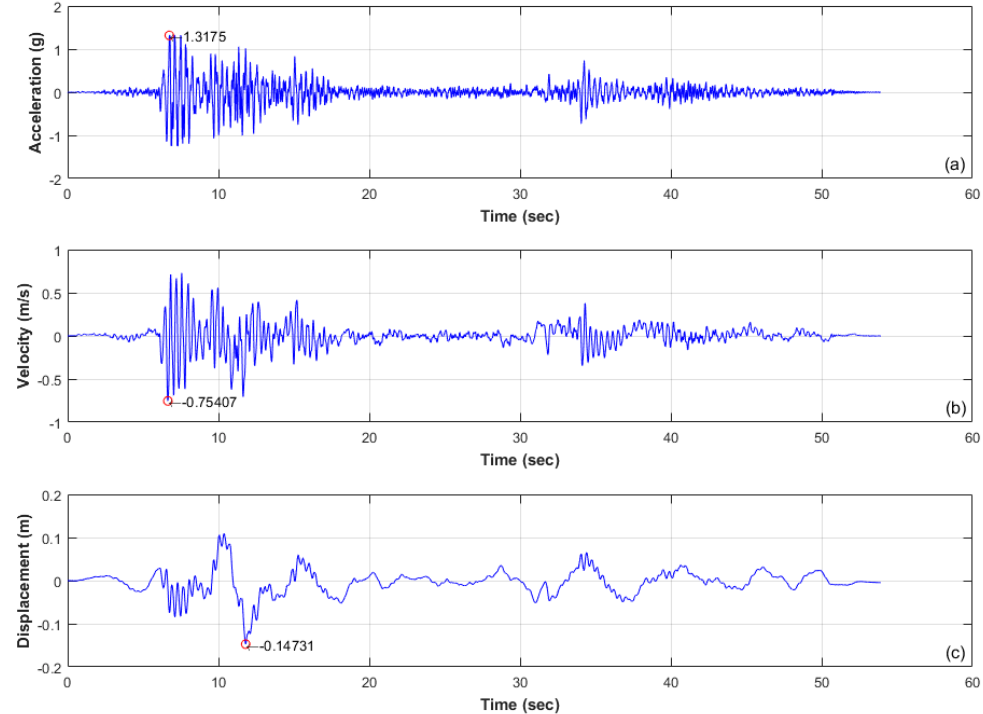
Figure 15. Analysis process for the 10th-story acceleration during the Manjil earthquake using Method 2; ( a ) acceleration; ( b ) velocity; ( c ) displacement.